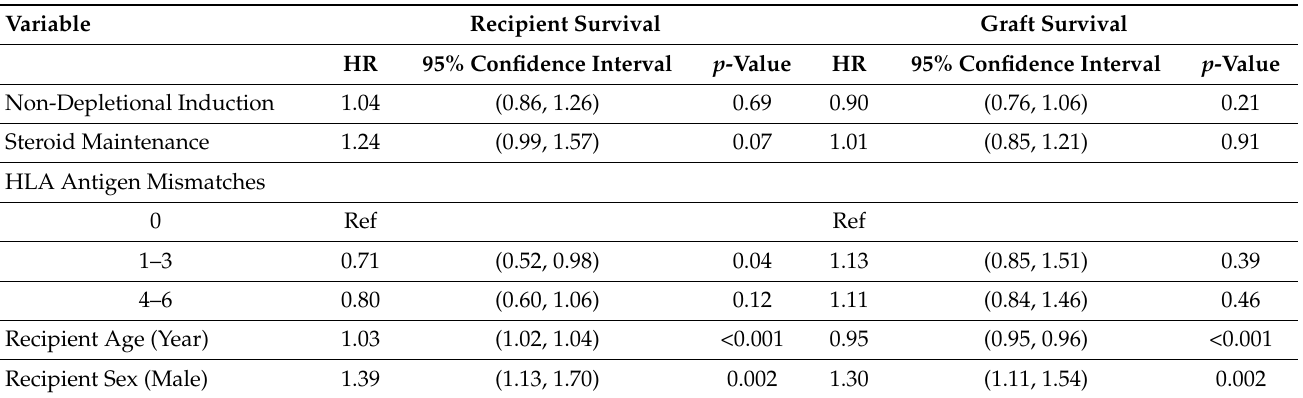
Figure 5. Univariable Kaplan–Meier Estimates of Recipient Survival (RS) and Death-Censored Graft Survival (DCGS) by Induction Type and Steroid Maintenance in SLE Related Glomerulonephritis. Table 3. Multivariable Cox Proportional Hazards Models for Recipient Survival and Death-Censored Graft Survival in SLE Related